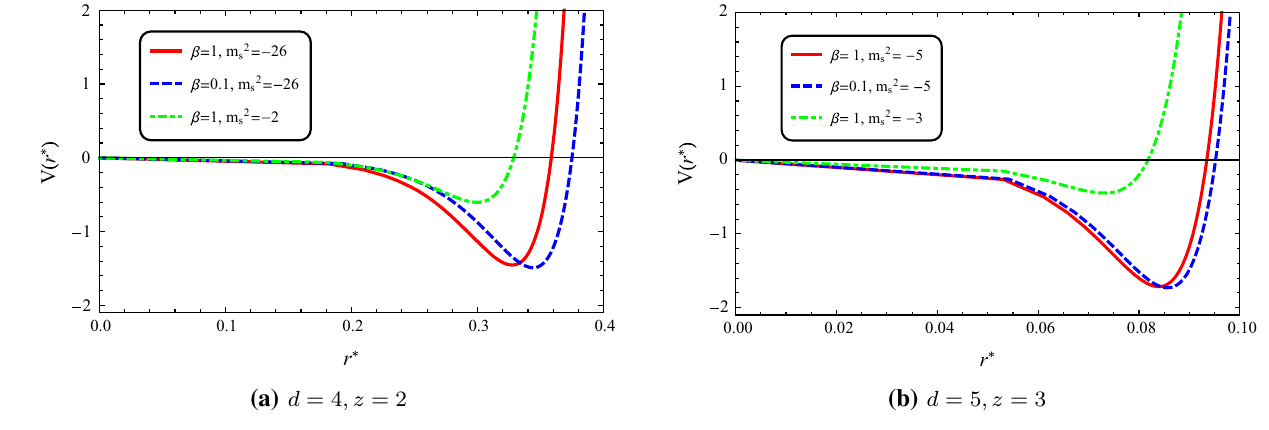
Fig. 4 The behaviors of V ( r ∗ ) in the case with d (cid:7)= z for different β and m 2 s